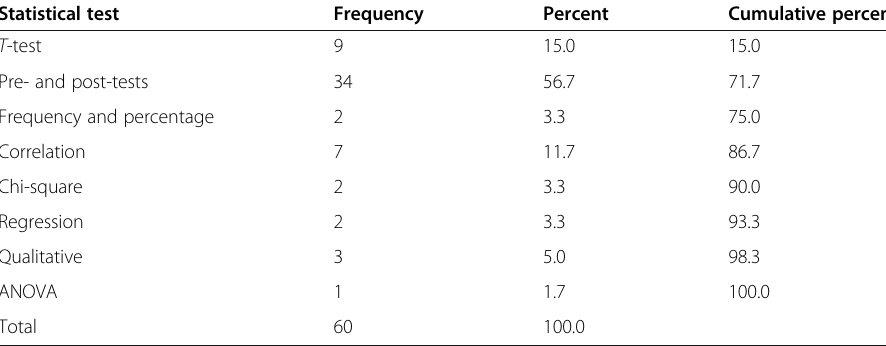
Table 4 Frequency distribution of researches by statistical test Statistical test Frequency